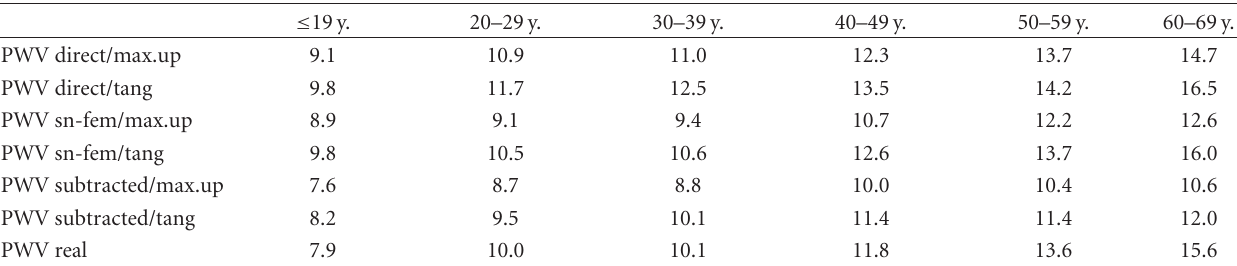
Table 3: PWV thresholds (reference population).